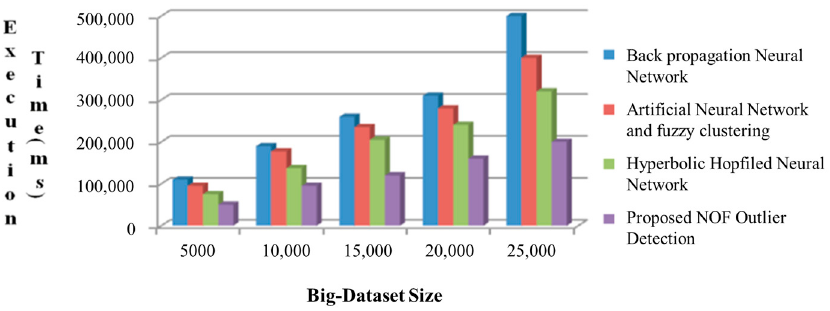
Figure 1. Big-Dataset size vs. execution time.